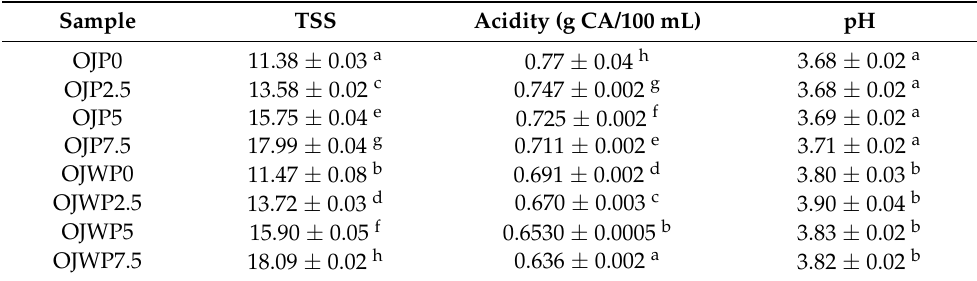
Table 1. Mean values (and standard deviations) of TSS, pH, and acidity of pasteurized orange juice.